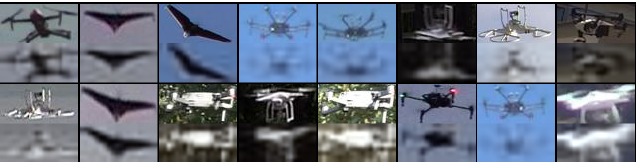
Figure 17. Examples of ESRGAN in given Dataset. The top row indicates original image, the bottom indicates respective GAN